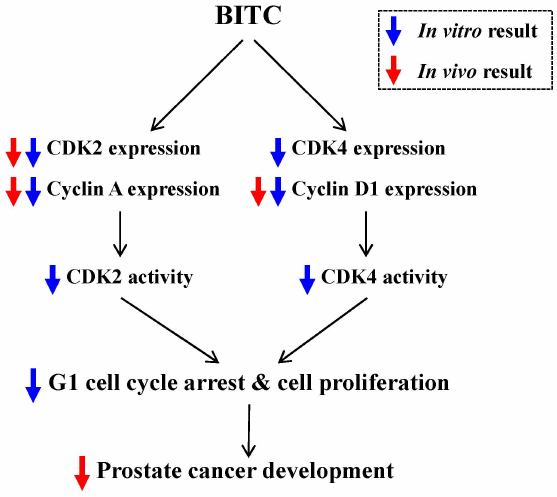
Figure 5. Proposed mechanisms by which BITC inhibits prostate cancer development. In vitro cell culture results (blue arrow) revealed that BITC treatment decreases the expression of CDK2, CDK4, cyclin A, and cyclin D1, as well as the activity of CDK2 and CDK4, thereby resulting in the induction of G1 cell cycle arrest. In vivo results (red arrow) revealed that BITC administration decreases the expression of CDK2, cyclin A, cyclin D1, and the number of Ki67 (a proliferation marker)-positive cells in the prostatic tissue, resulting in decreases in prostate cancer